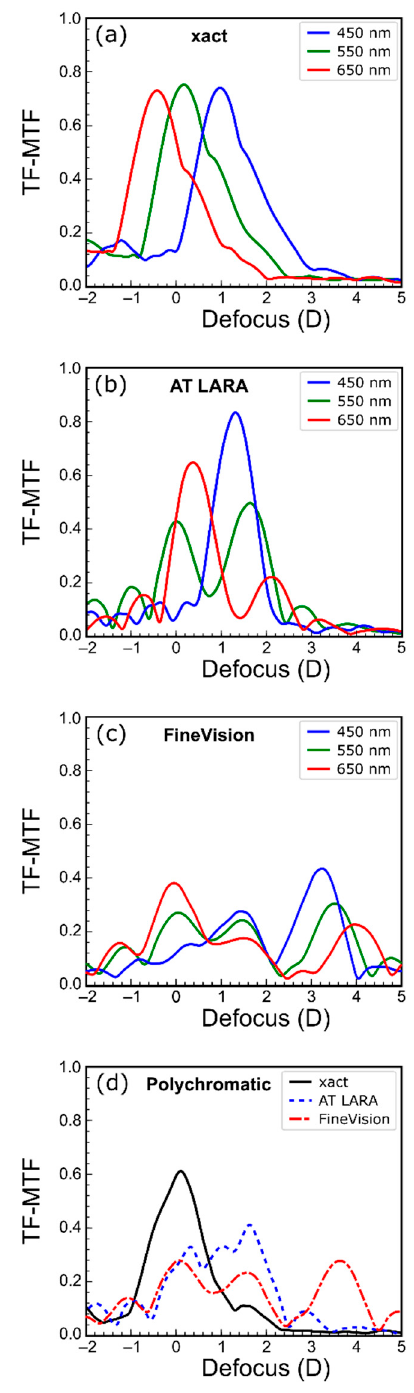
Figure 3. Experimental TF-MTFs obtained for the ( a ) xact, ( b ) AT LARA, and ( c ) FineVision for different wavelength monochromatic illuminations (450 nm, 550 nm, and 650 nm), and ( d ) for the three IOLs with polychromatic illumination.